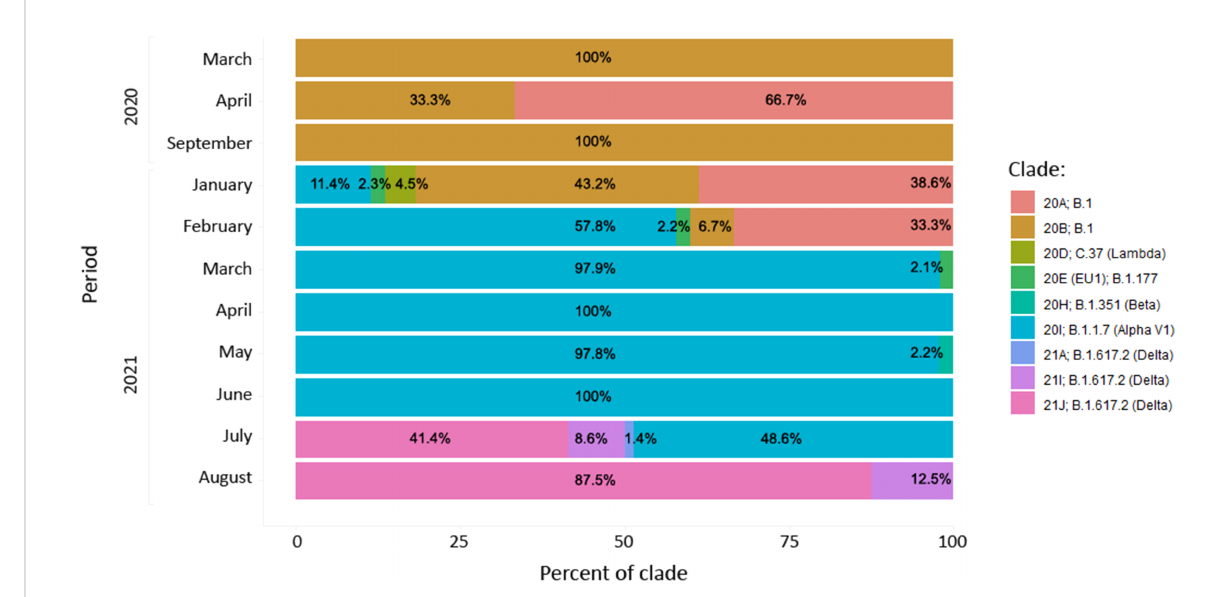
FIGURE 7 Distribution of SARS-CoV-2 clades in the period between March 2020 and August 2021.